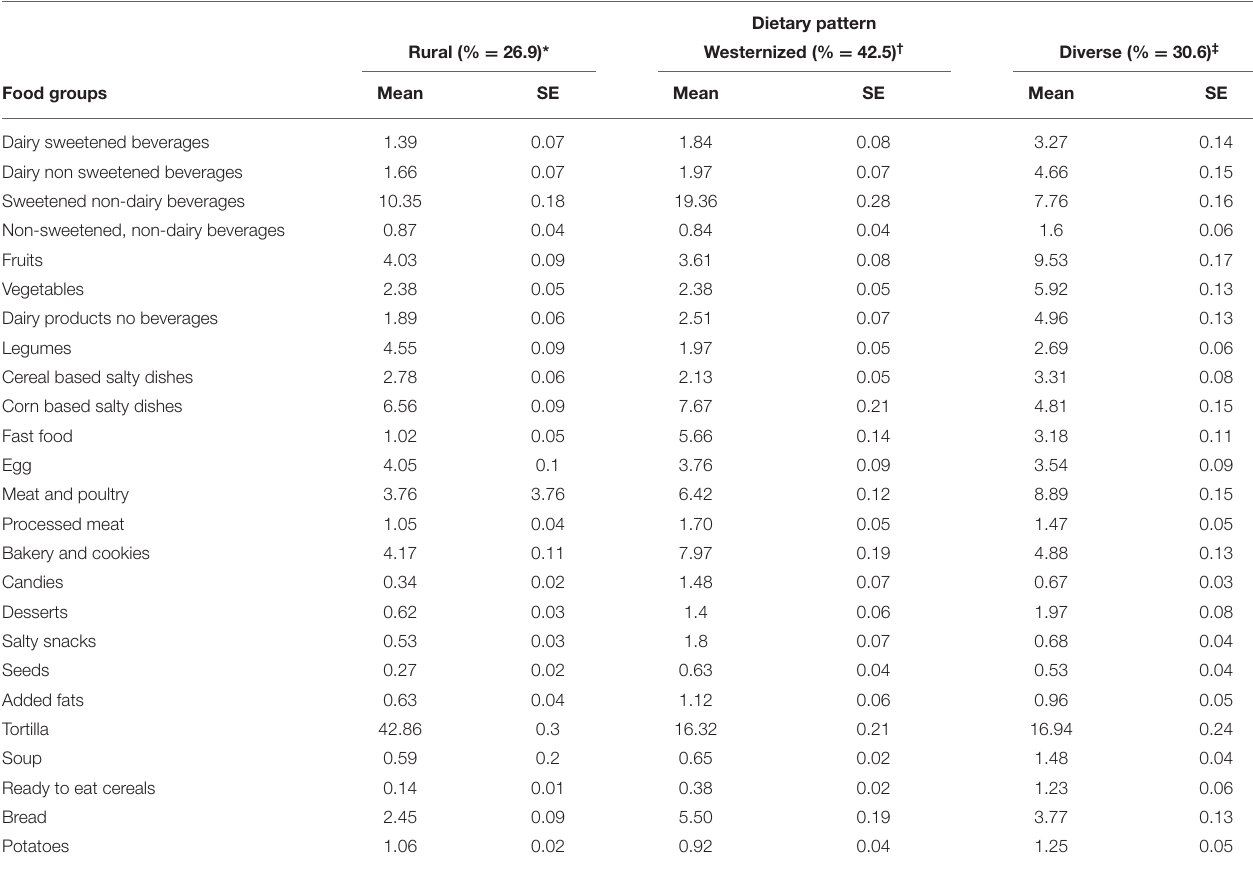
TABLE 2 | Contribution of energy (%) by food group and dietary pattern. Dietary pattern Rural (% = 26.9)* Westernized (% = 42.5) † Diverse (% = 30.6)